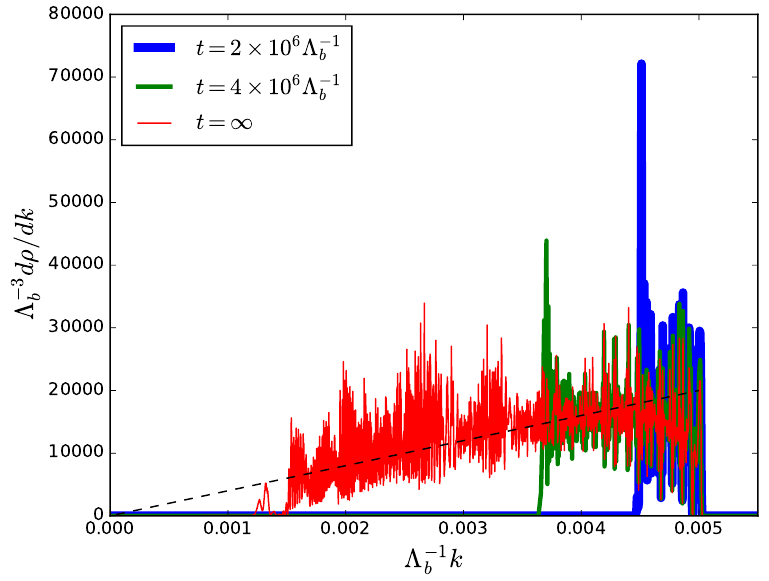
Figure 16 . Energy spectrum of the (cid:13)uctuations. We took the same parameters as (cid:12)gure 11. The black line shows eq. (4.2).